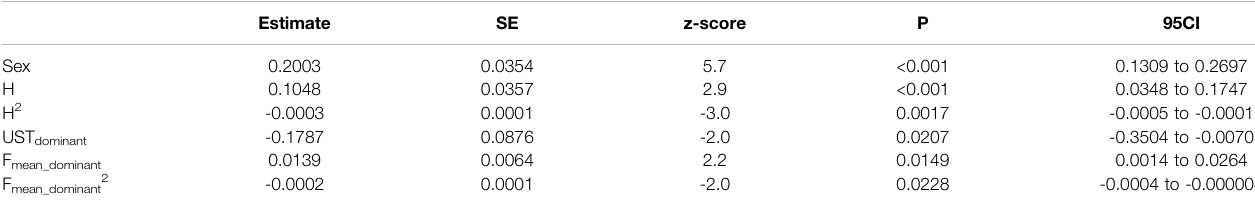
TABLE 2 | Fixed effects of the fi nal swimming velocity model computed with standard errors (SE), 95% con fi dence intervals (95CI), test-score (z-score), and signi fi cance value